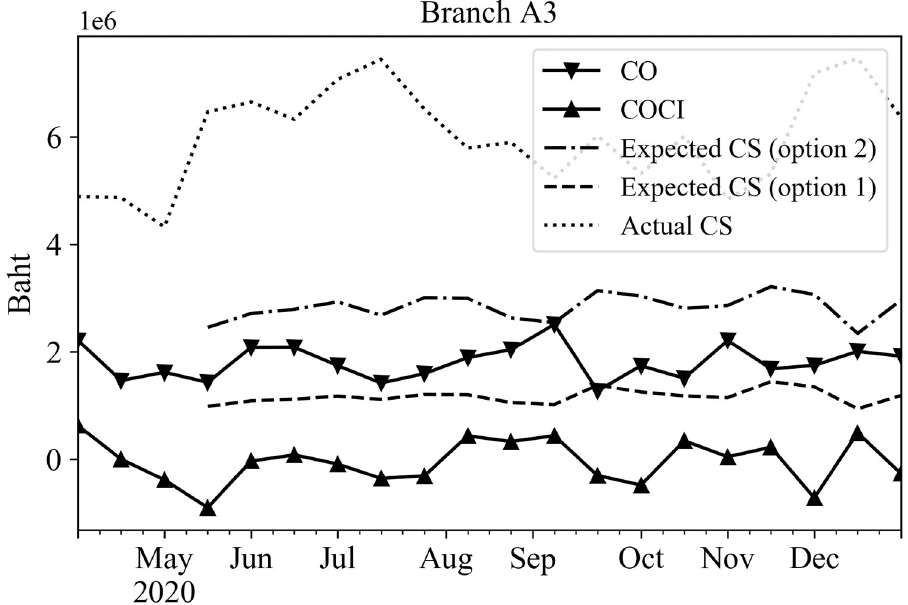
Fig 10. Expected and actual cash stocks, CO, and COCI of an example branch that opens every